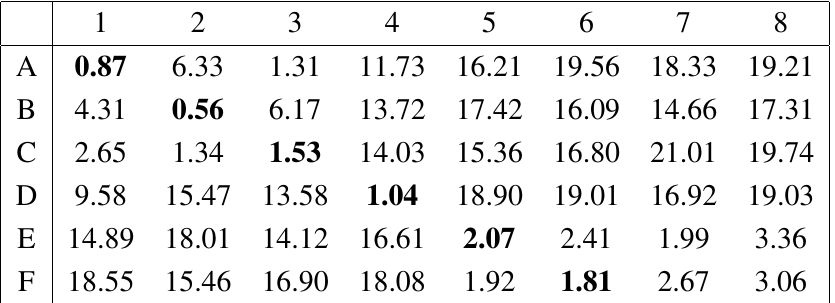
Table 1. SIFT-style Descriptor Similarity. This table lists Euclidean distances in radians, between the SIFT-like descriptors of detected features, shown in Figure 12. In each case, the correct match has very small descriptor distance.